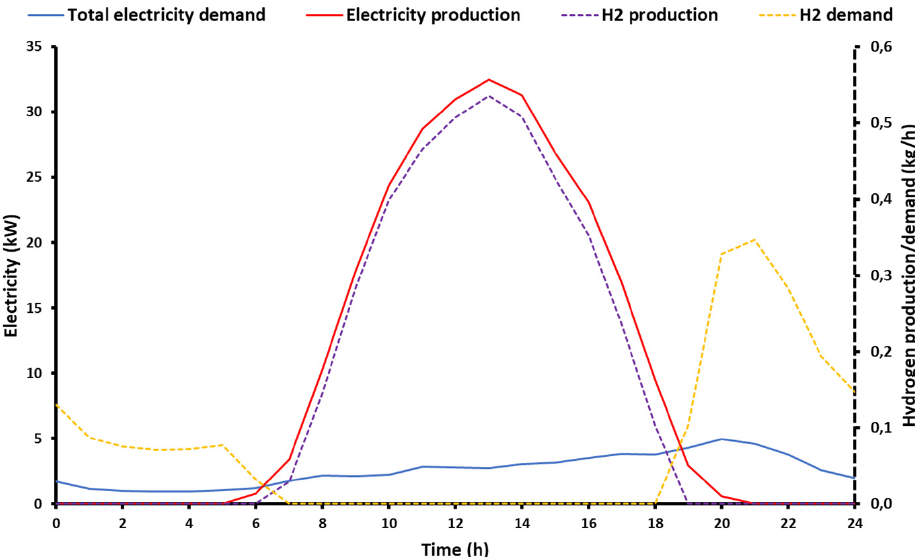
Figure 12. Summer Day: Variation in the electricity demand/production and hydrogen demand/pro- duction.